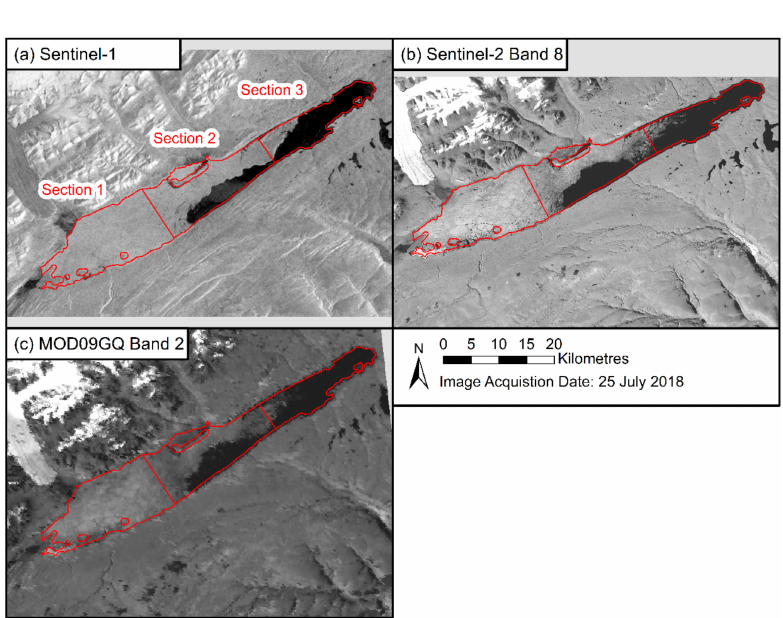
Figure 2. Comparison between ( a ) Sentinel-1, ( b ) Sentinel-2, and ( c ) moderate resolution imaging spectroradiometer (MODIS) images for 25 July 2018. The red outlines show the di ff erent sections created to divide the lake. This figure contains Copernicus Sentinel-1 data (2018), processed by European Space Agency (ESA) and Copernicus Sentinel-2 data (2018), processed by the